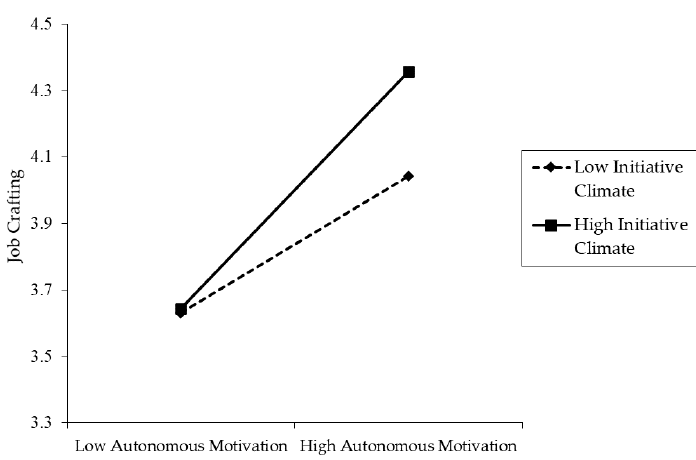
Figure 2. Interactive effects of individual-level autonomous motivation × organization-level initiative climate on job crafting.